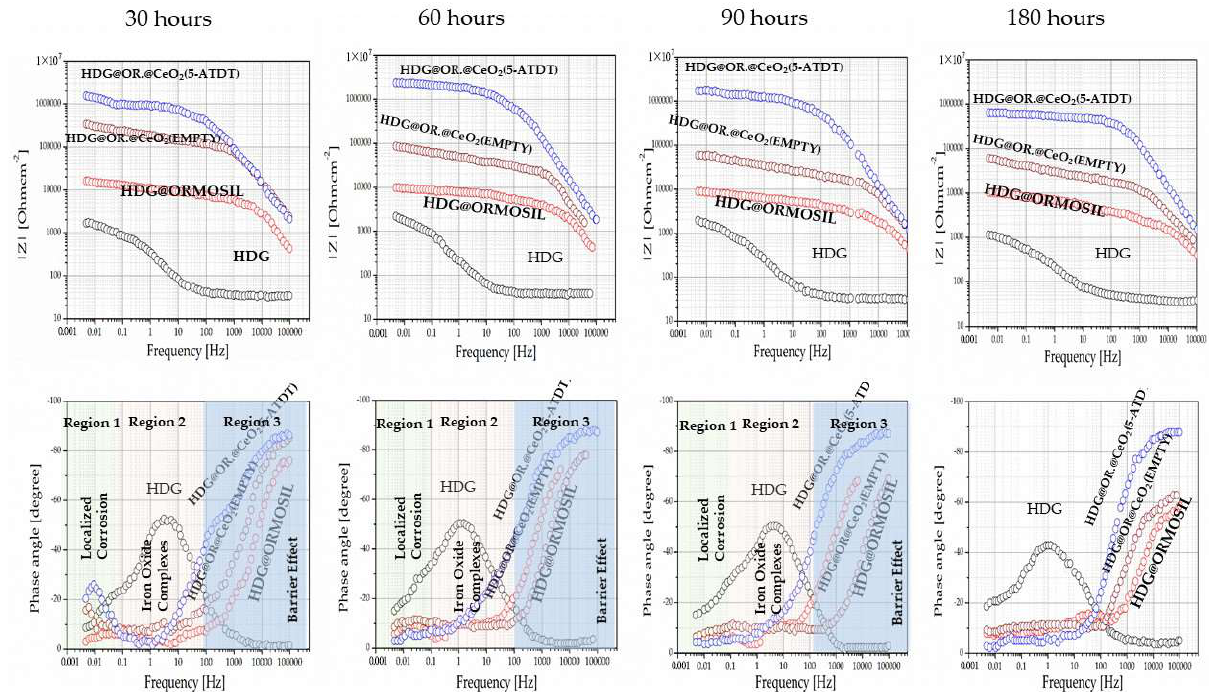
Figure 5. EIS bode sample diagrams: uncoated galvanized steel, HDG-ORMOSIL, HDG-ORMOSIL + CeO 2 (EMPTY), HDG-ORMOSIL + CeO 2 (5-ATDT) after exposure to a solution of 0.5 M NaCl at ambient temperature for 30, 60, 90, and 180 h.